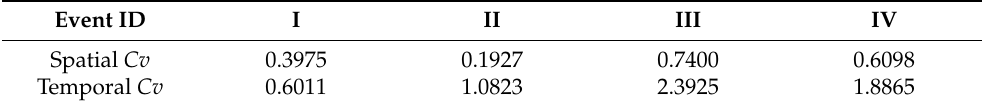
Table 3. Rainfall evenness of the four selected 24-h storm events in space and time.